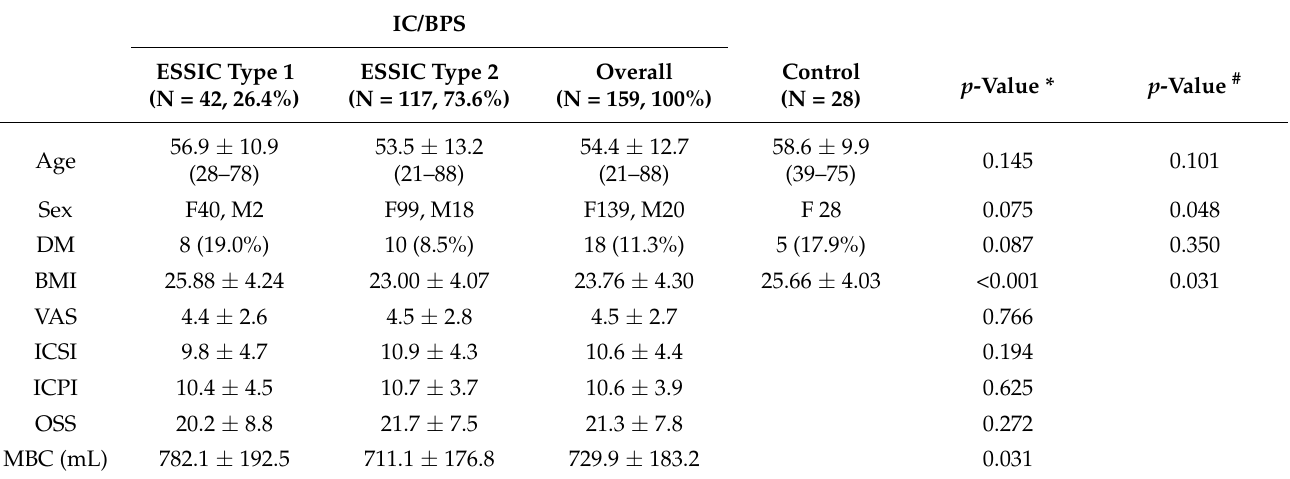
Table 1. Clinical characteristics of patients with IC/BPS and the control patients. IC/BPS